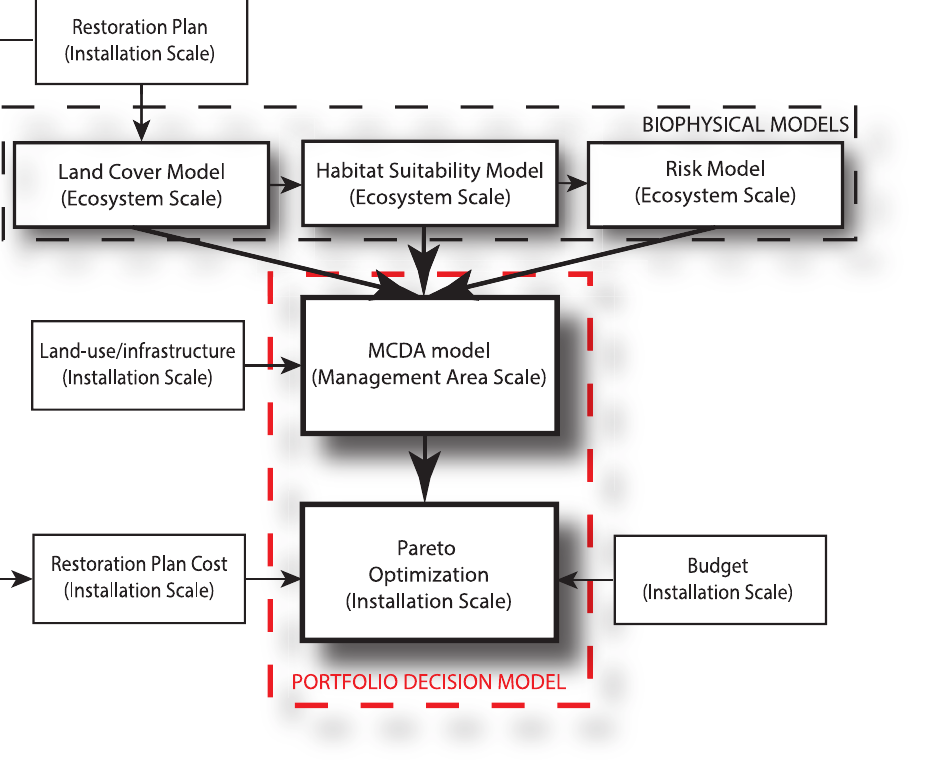
Figure 3. Diagram of the modeling framework. The Multi Criteria Decision Analysis model (MCDA) evaluates restoration actions for each human and natural asset at the management area scale. Outputs of biophysical models at 120 m resolution are averaged at the management area scale (3750 m). These models are run at the whole ecosystem scale that is the population scale (Figure 1) if assets are species. These outputs are part of the criteria in the MCDA model. The risk model modifies the MCDA values by considering the vulnerability of the restoration plan for each asset at the ecosystem scale and the effectiveness of each action at the management area scale (Eq. 2). The expected values of restoration actions are the inputs of a Pareto optimization model together with the cost of the restoration plan and the constraint of the budget at the installation scale. The Pareto optimization provides Pareto frontiers of optimal restoration plans at each year in the management horizon (Figure 4).